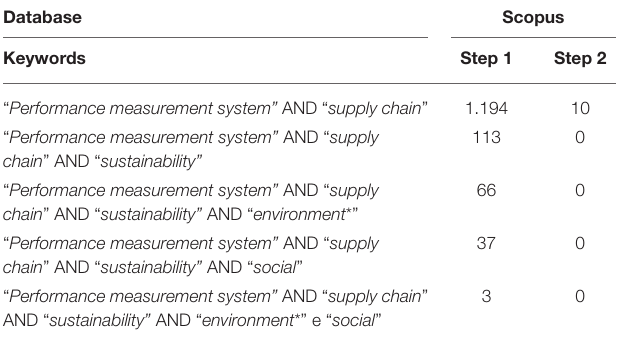
TABLE 1 | Results after steps 1 and 2 of the bibliographic database. TABLE 2 | Summary of supply chain performance measurement systems surveyed in the